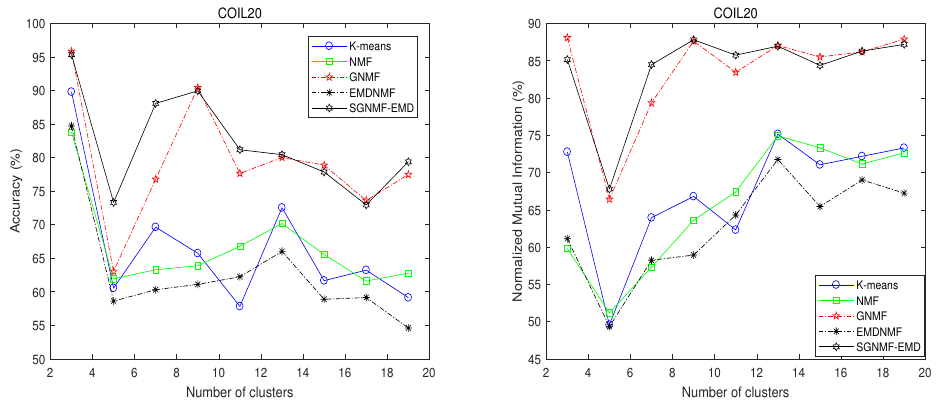
Figure 1. Clustering performance comparisons on the COIL20 dataset.